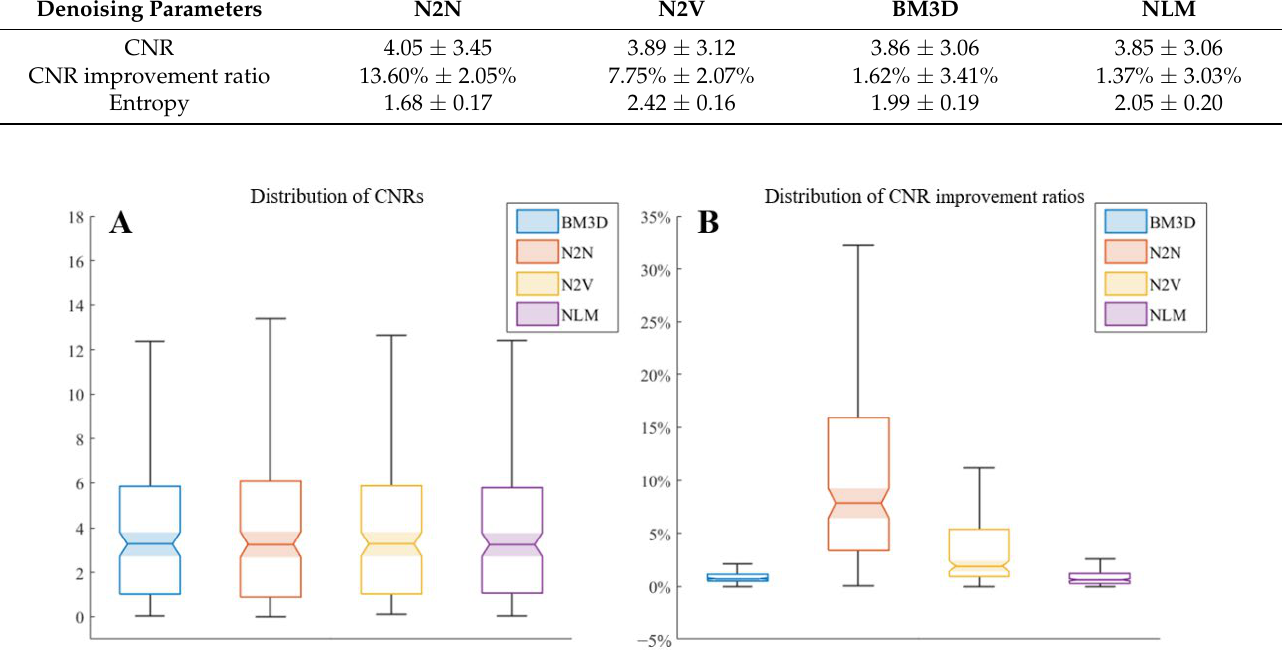
Table 3. Values of CNRs, CNR improvement ratios and entropy presented by N2N, N2V, BM3D and NLM.